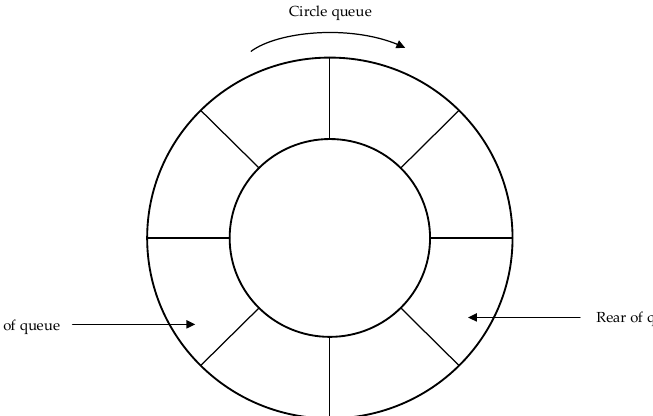
Figure 10. Schematic diagram of the circle queue.